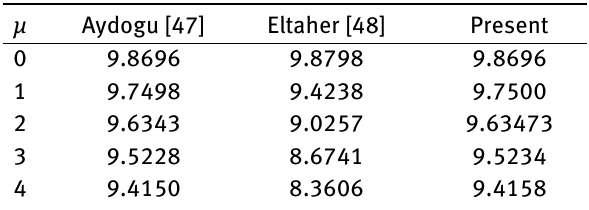
Table 5: Comparisons of first fundamental frequency parameter ( λ ) for SS Nano